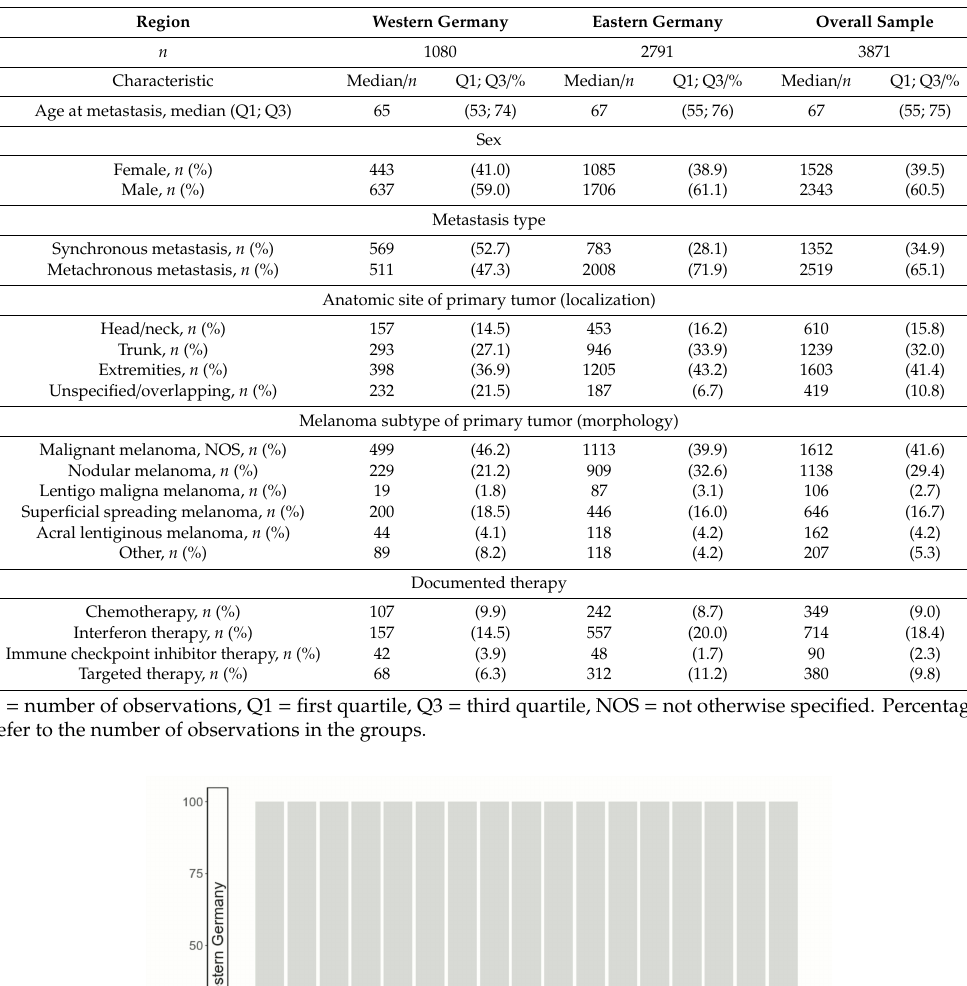
Table 1. Characteristics of the study cohort and important subgroups.